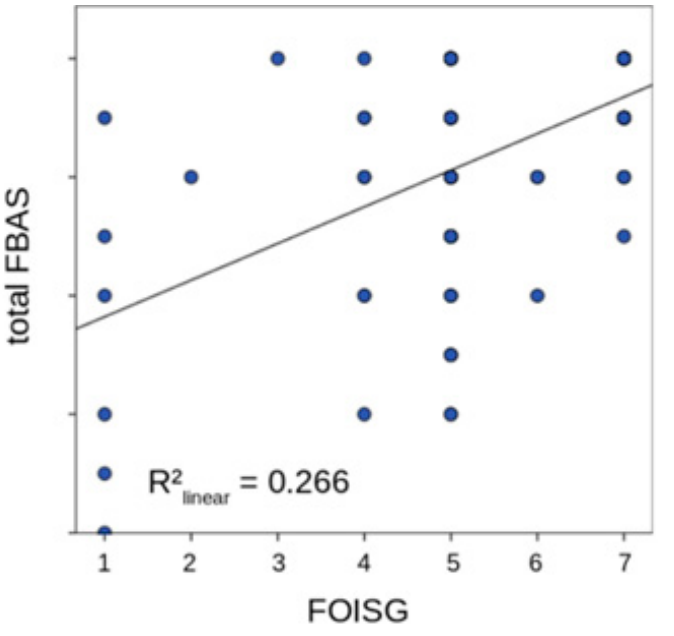
Figure 2. Correlation of the Functional Bedside Aspiration Screen (FBAS) to Functional Oral Intake Scale (FOIS).